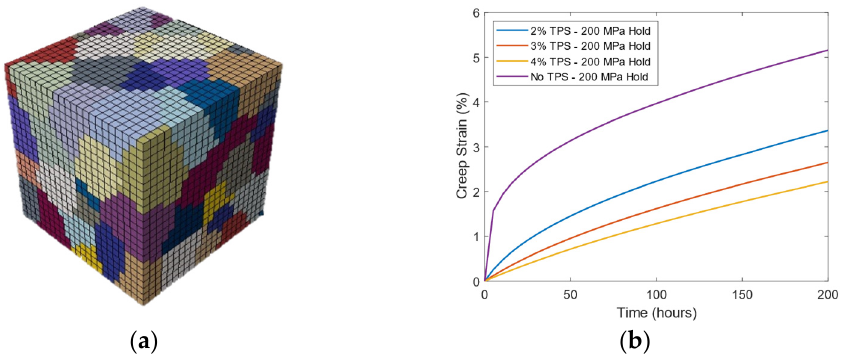
Figure 5. ( a ) RVE containing 97 grains. ( b ) CP simulation results showing the same trend witnessed in experimentation.